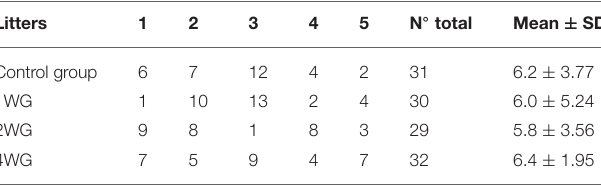
TABLE 1 | Number of puppies in each litter in the 4 study groups.